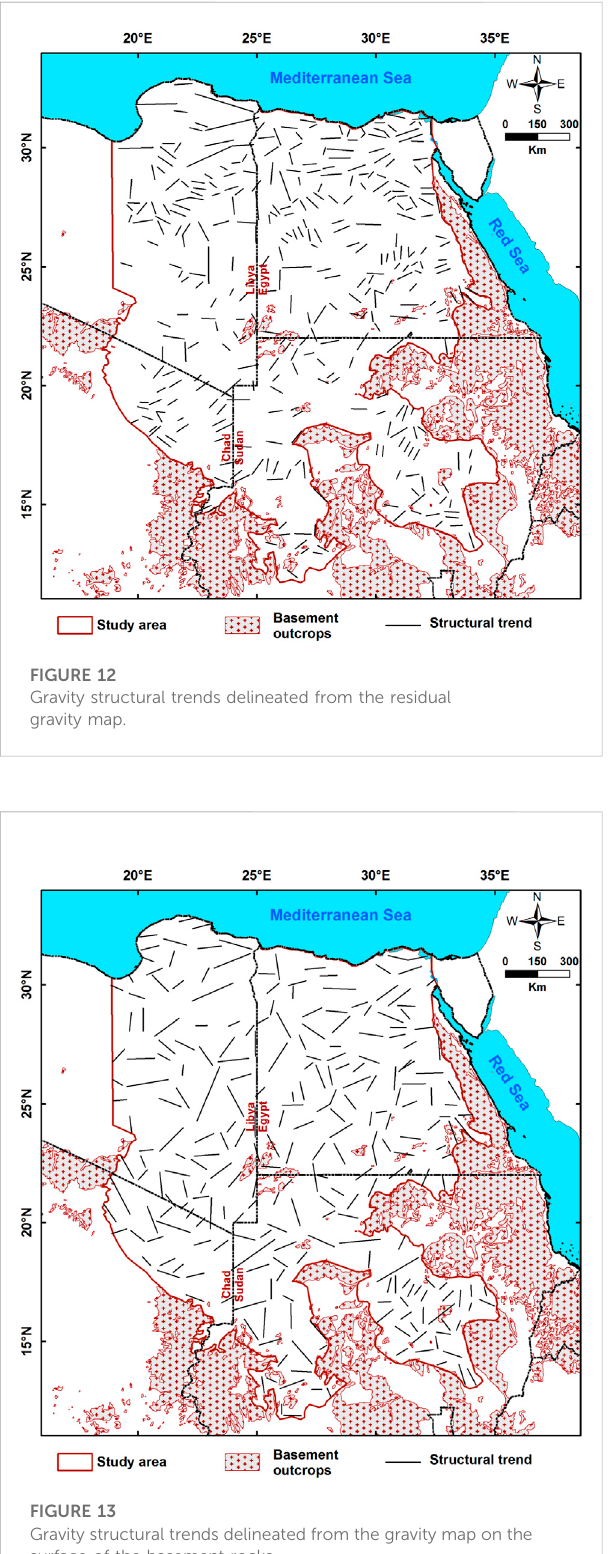
FIGURE 13 Gravity structural trends delineated from the gravity map on the surface of the basement rocks.